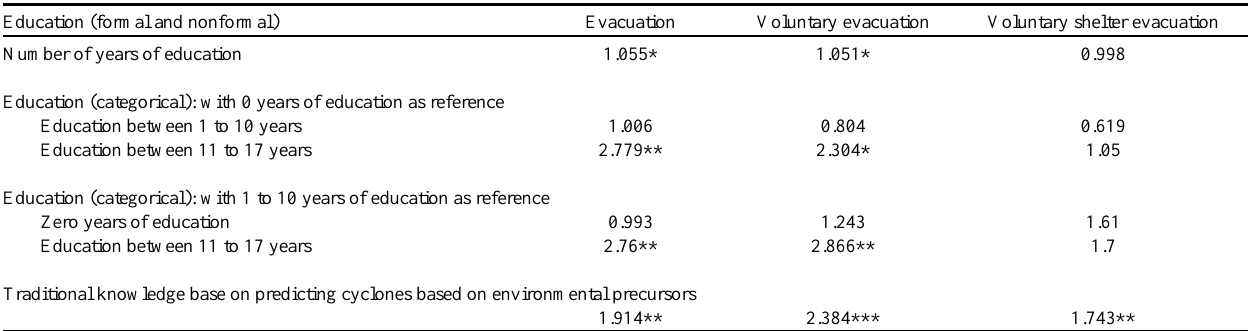
Table 2 . Bivariate logistic regression of formal education and traditional knowledge base on